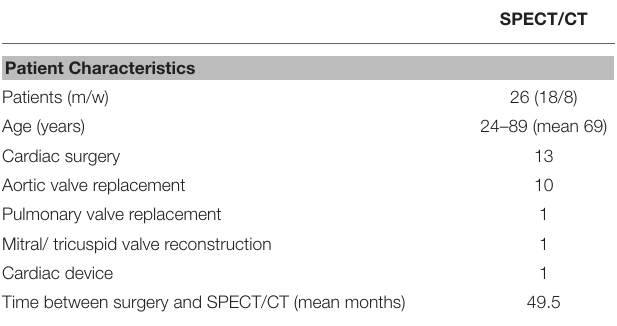
TABLE 1 | Patient